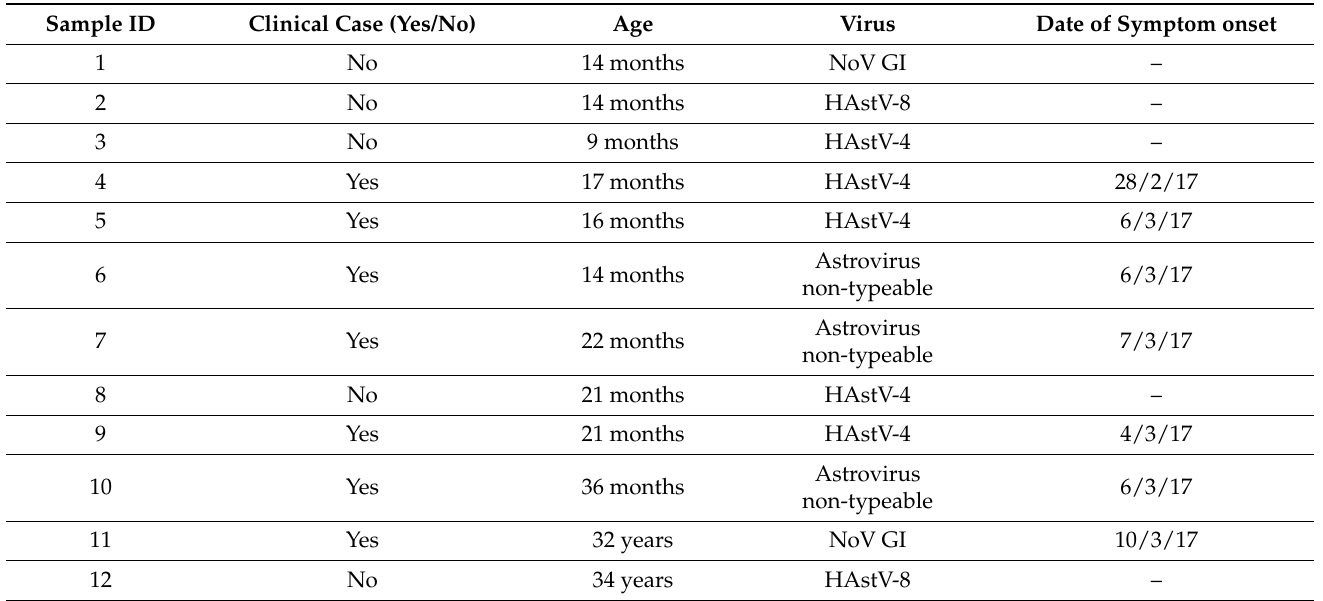
Table 2. Samples from exposed people with viruses identified by RT-PCR